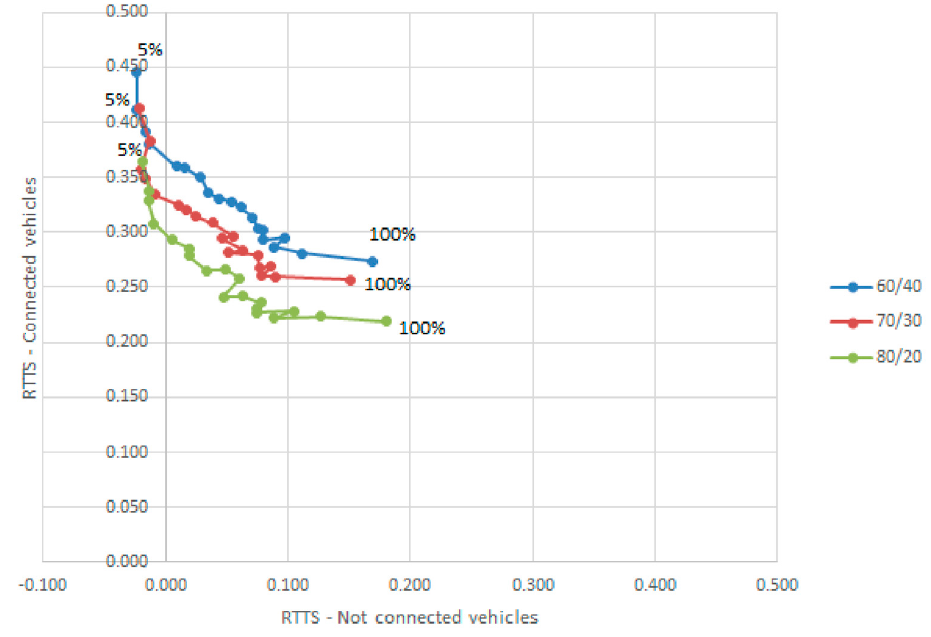
Figure 14. Competition-Cooperation diagram on a daily base in Case A.